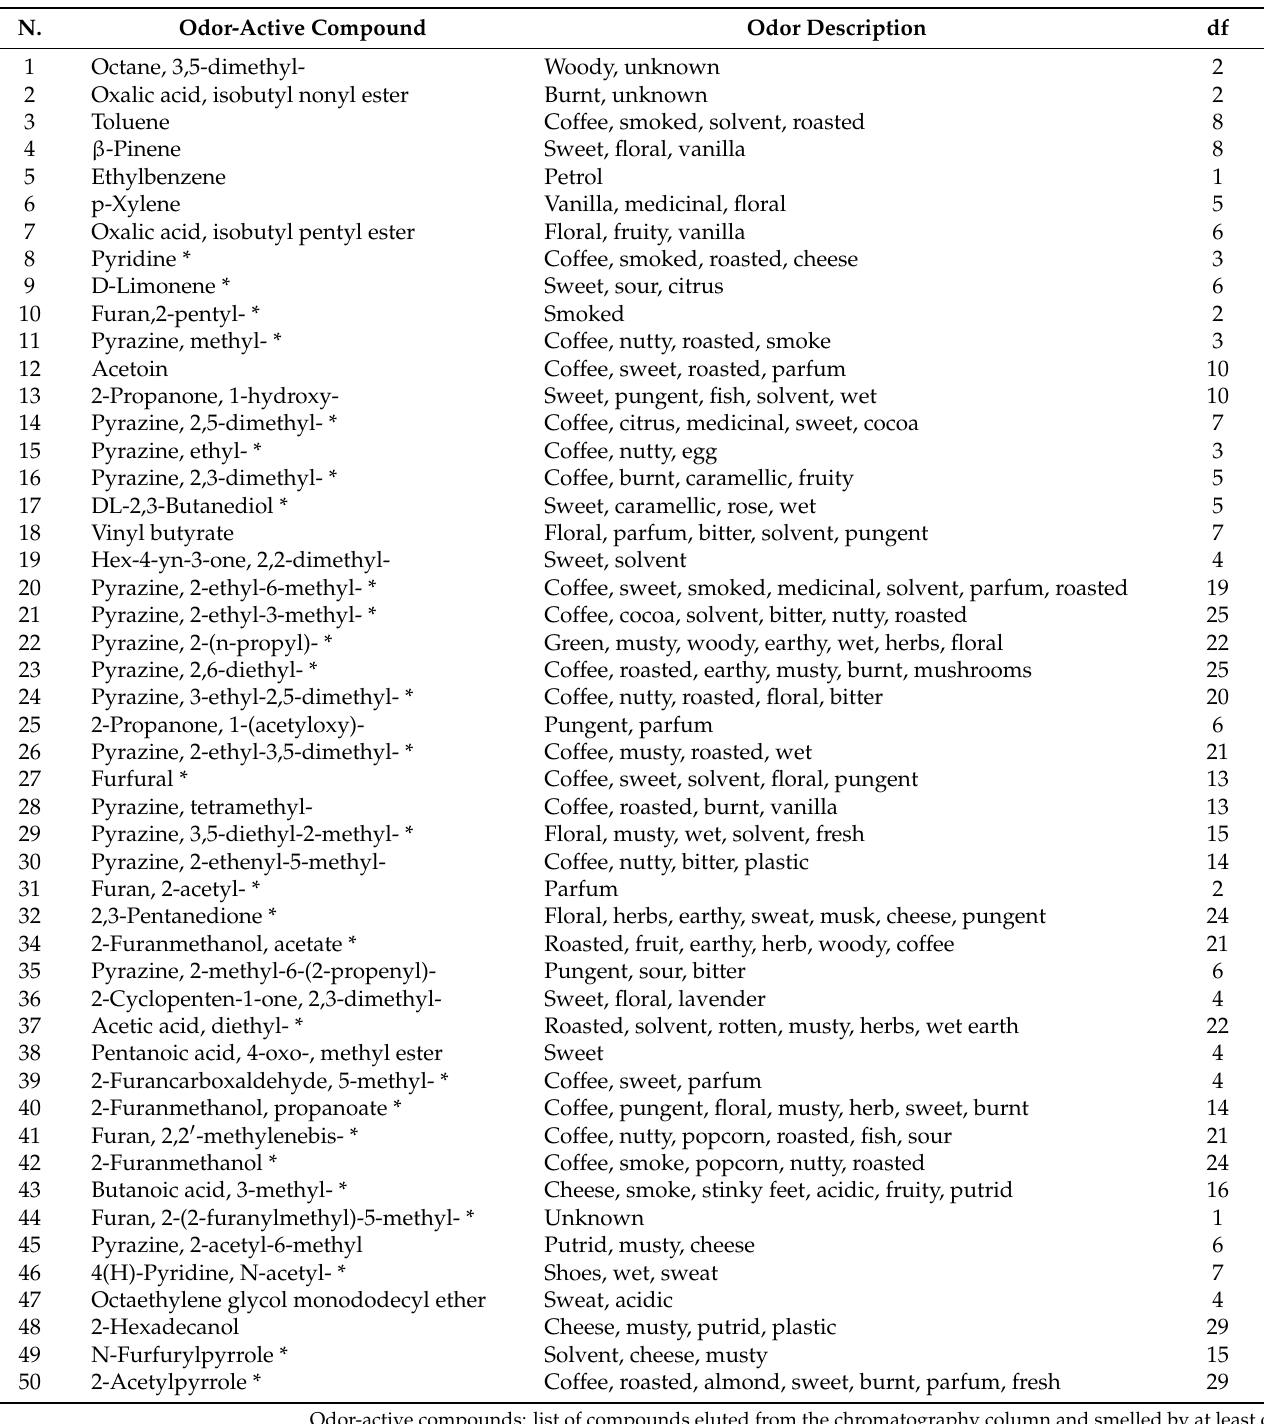
Table 2. GC-O analysis: odor-active compounds and odor descriptions by